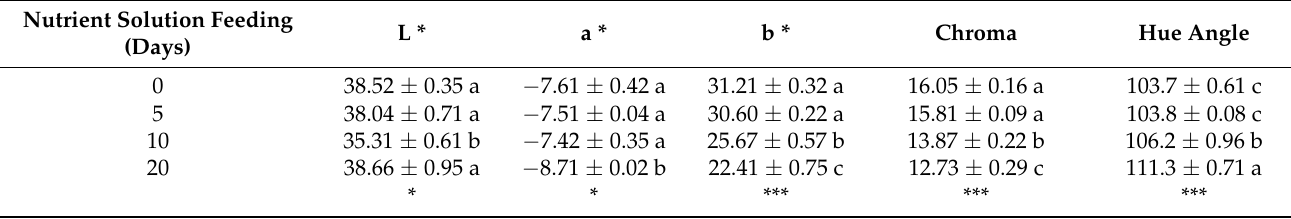
Table 1. CIELAB color space parameters, chroma, and hue angles of spinach microgreens in relation to nutrient solution feeding